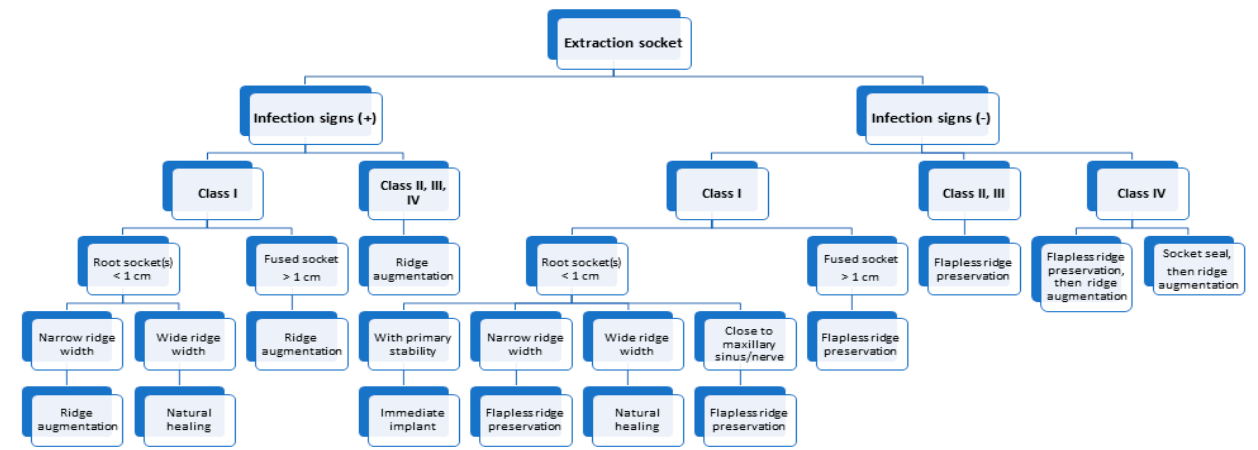
Figure 2. Treatment flowchart of management for extraction socket depending on Chang’s